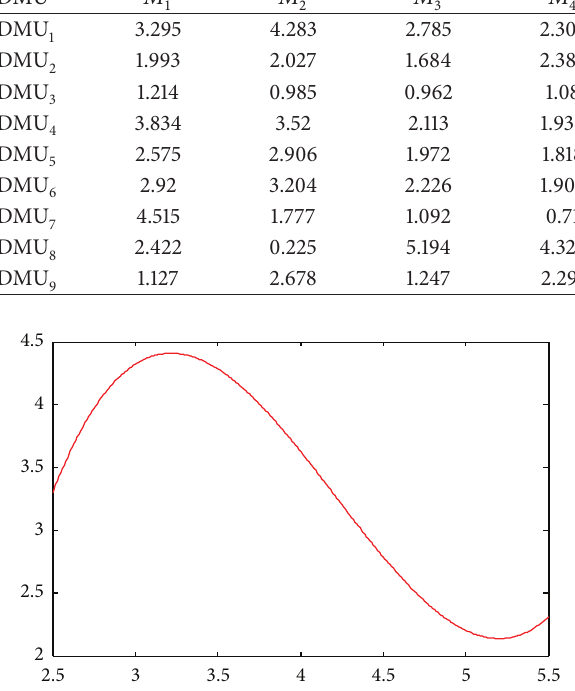
Figure 1: The diagram of Malmquist product index DMU 1 .